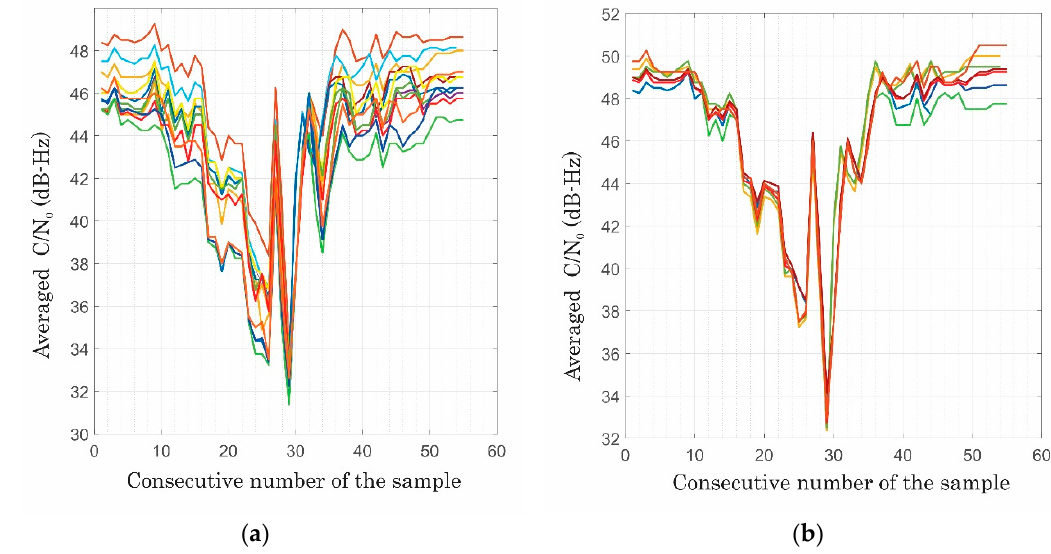
( b ) Figure 7. Skyplot of visible satellites for 16 July 2019: ( a ) at the beginning of the experiment 08:20:00